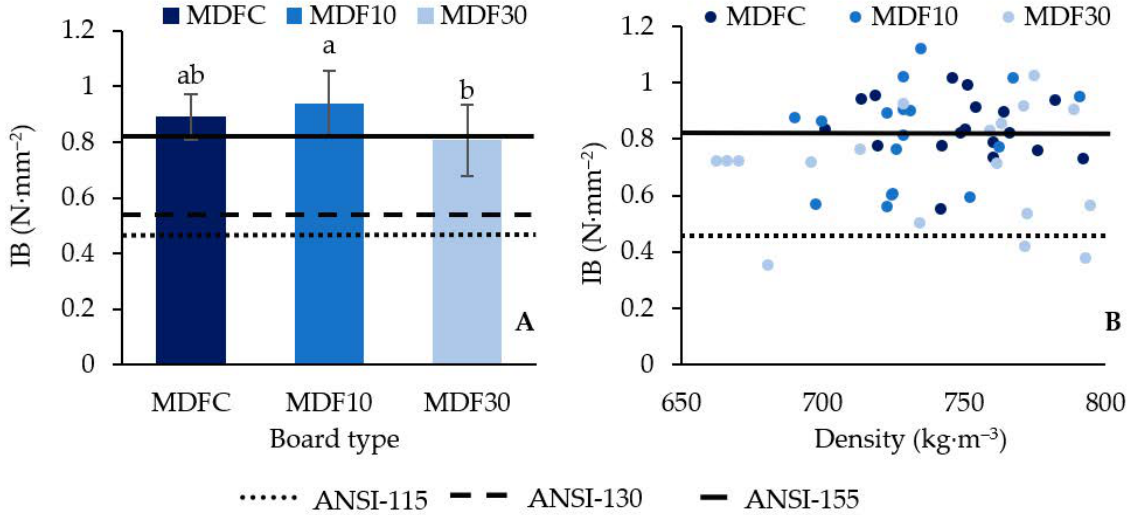
Figure 4. Internal bond of MDF panels ( A ) Internal bond of MDF panels. Different lowercase letters represent statistically significant difference among panels by Tukey test ( p ≤ 0.05). p value of ANOVA for internal bond is 0.0195. ( B ) Internal bond as a function of density of MDF panels. Lines represent MDF standard requirement for 115, 130, and 155 grades according to ANSI A208.2-2016.